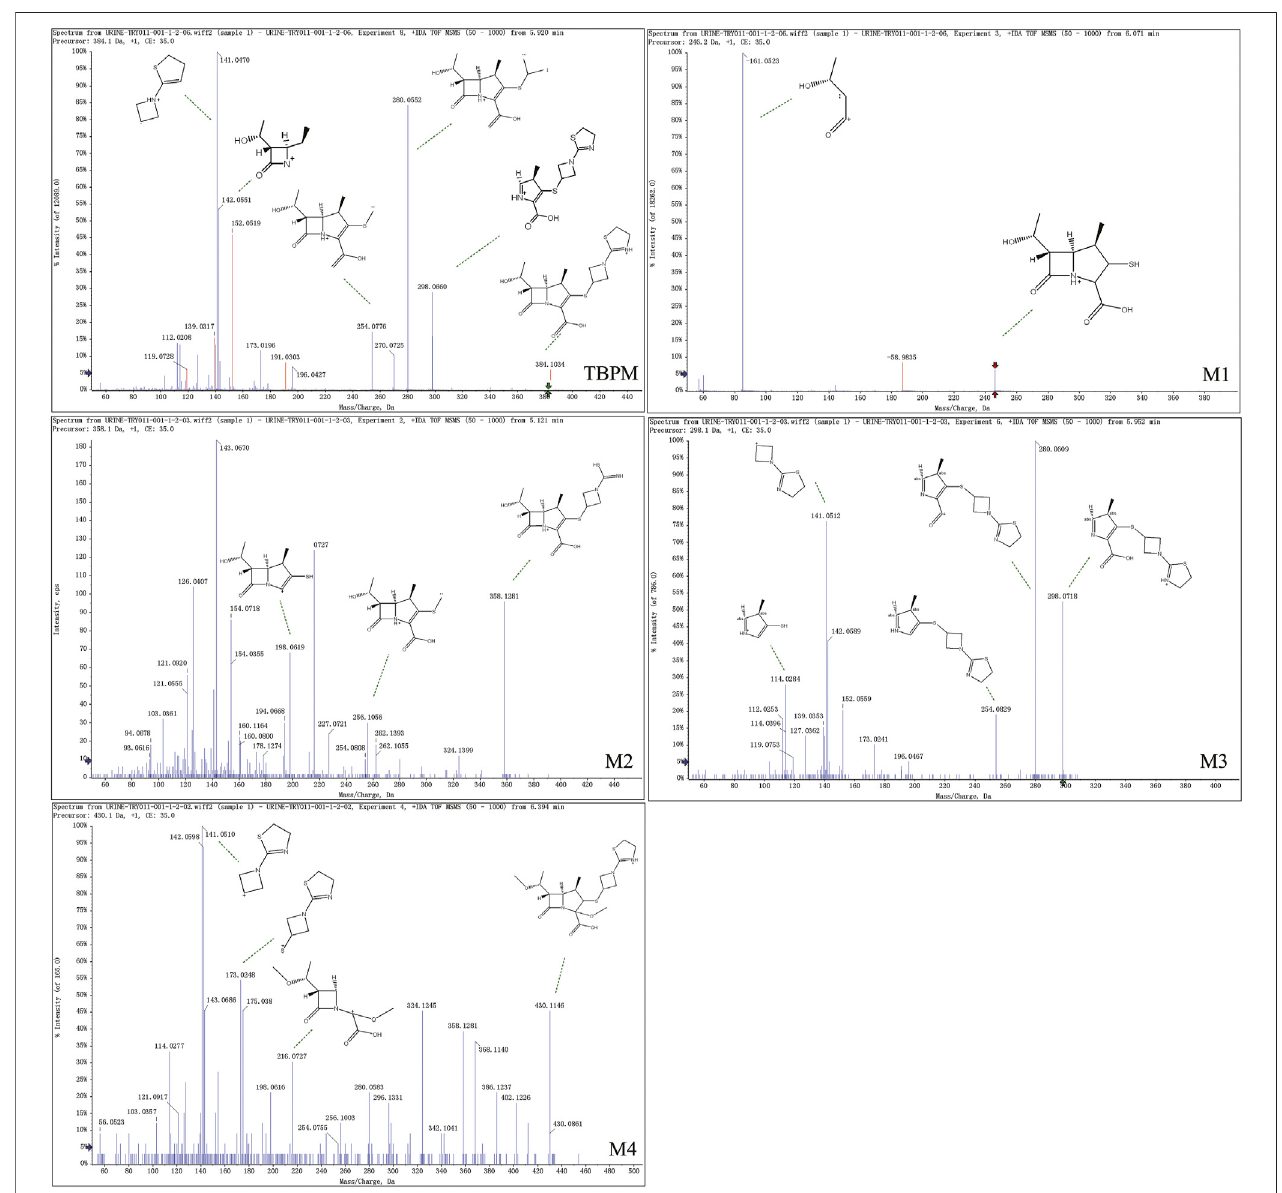
FIGURE 4 | The MS 2 spectrum of TBPM, M1, M2, M3, M4, and fragment ions in the positive ion mode.